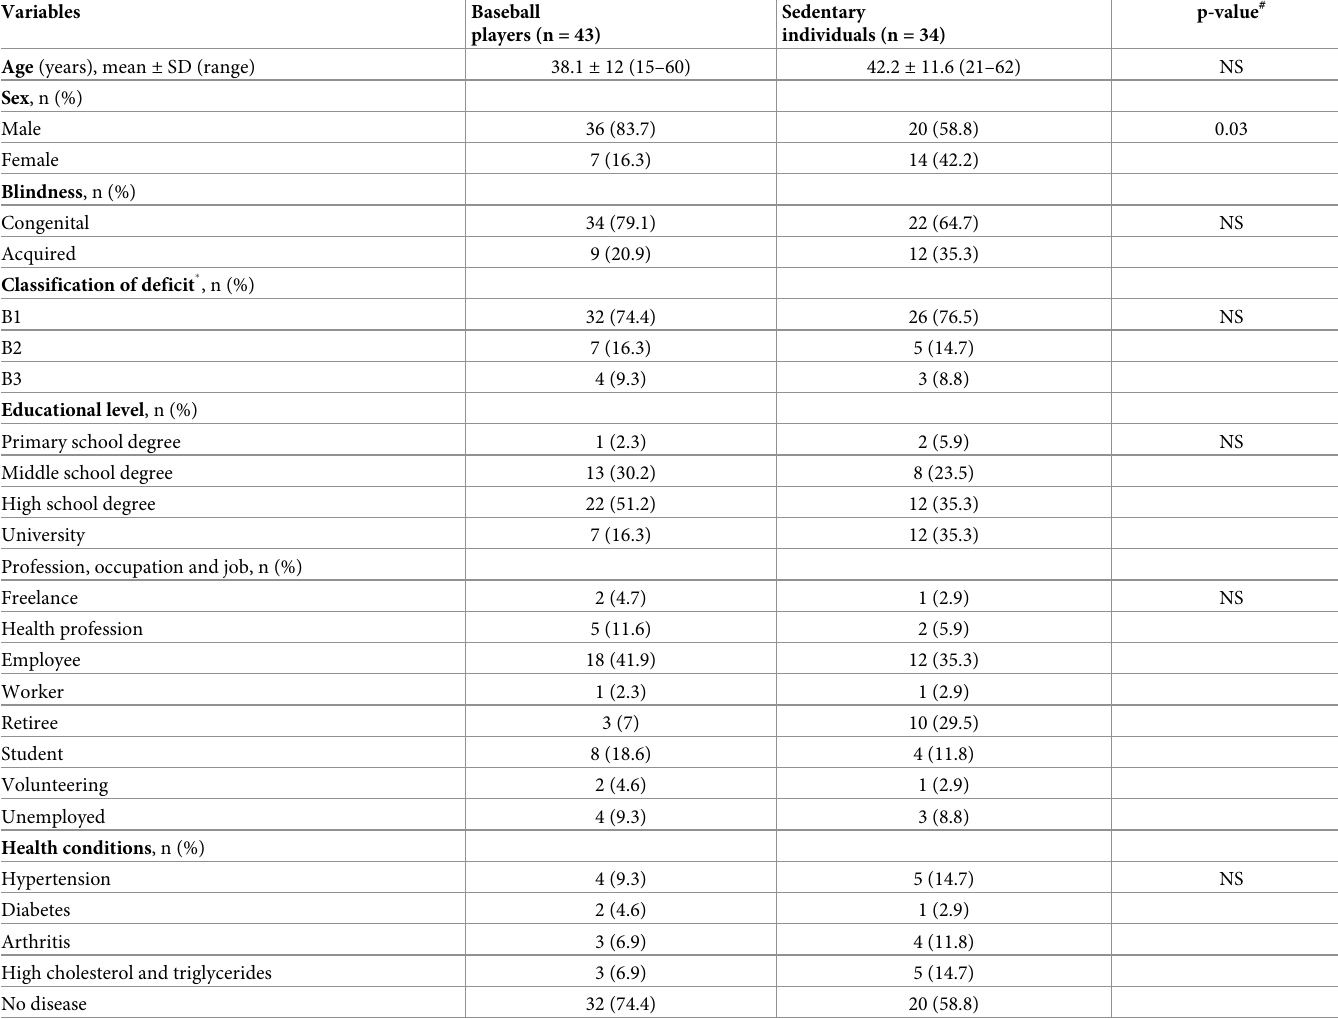
Table 2. Demographic data, description of visual disability and general health conditions of visually impaired subjects playing baseball and visually impaired seden- tary individuals. Variables